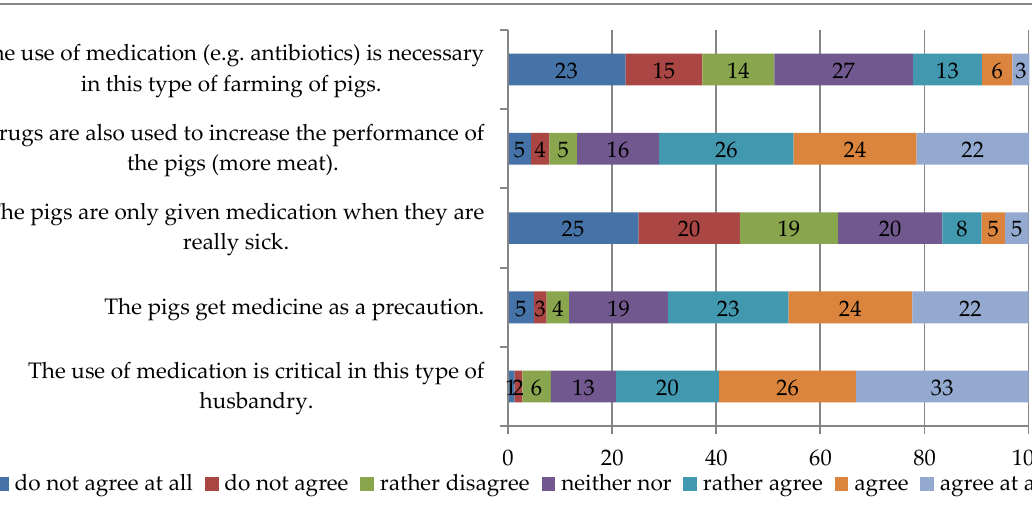
Figure 7. Frequency distribution of the statements regarding medical treatment.